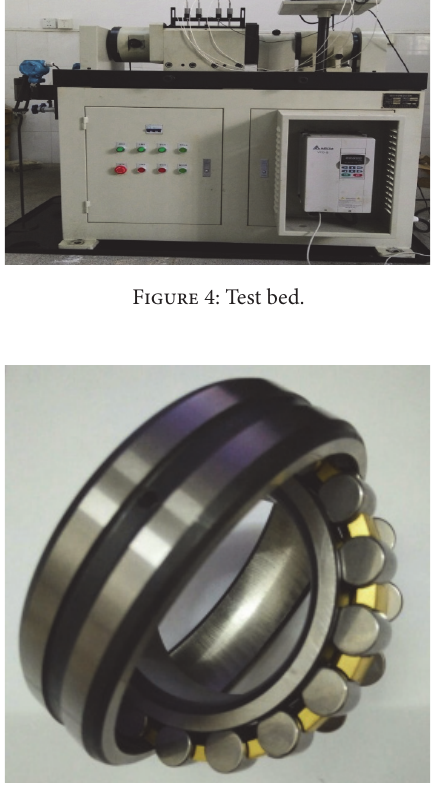
Figure 5: Rolling element bearing.